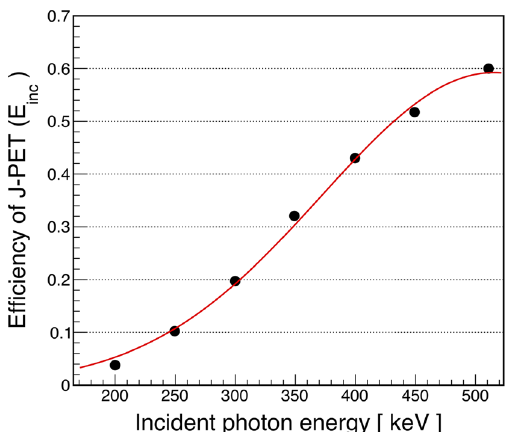
Fig. 11 The intrinsic efficiency of the J‑PET scanner as a function of the energy of the incident photon is shown by the black‑filled circles. The red line shows the fitting function described in the